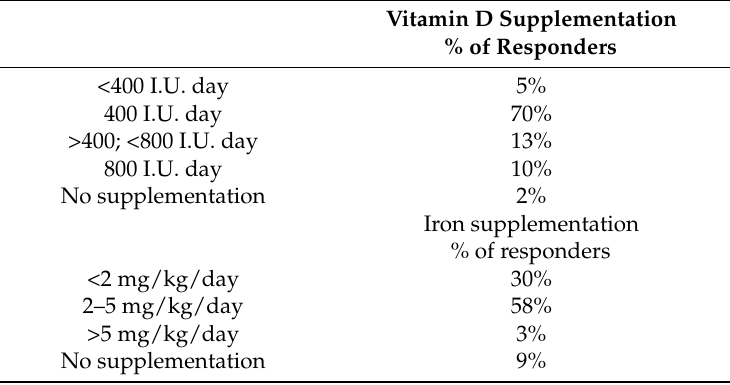
Table 3. Doses of Iron and Vitamin D